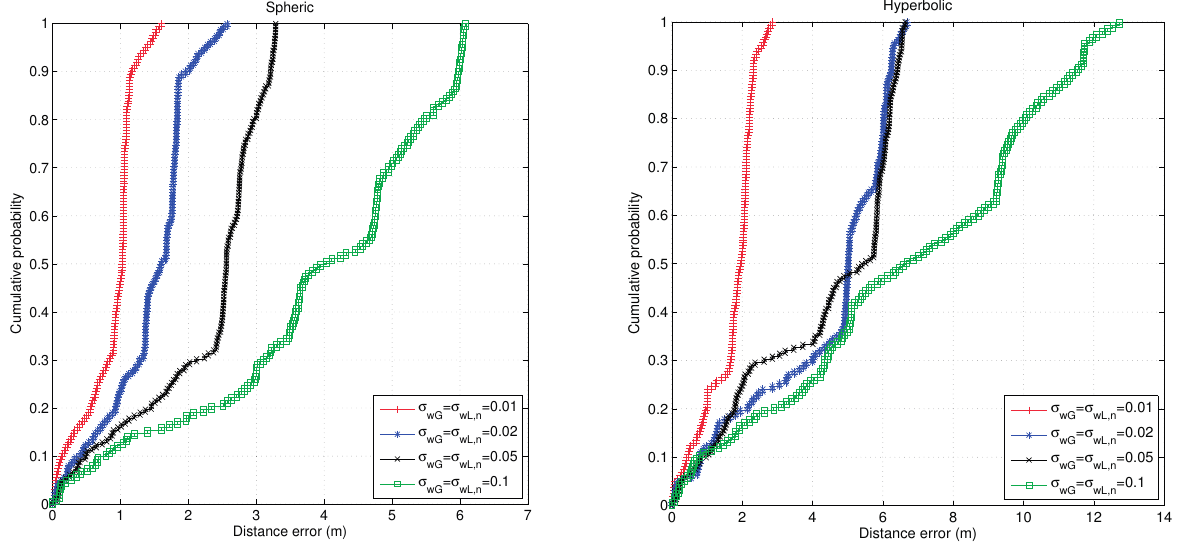
Figure 9. cdf of the navigation errors for different ultrasonic distance error conditions assuming that the odometry errors remain constant. ( Left ) Spherical case; ( right ) hyperbolic case.